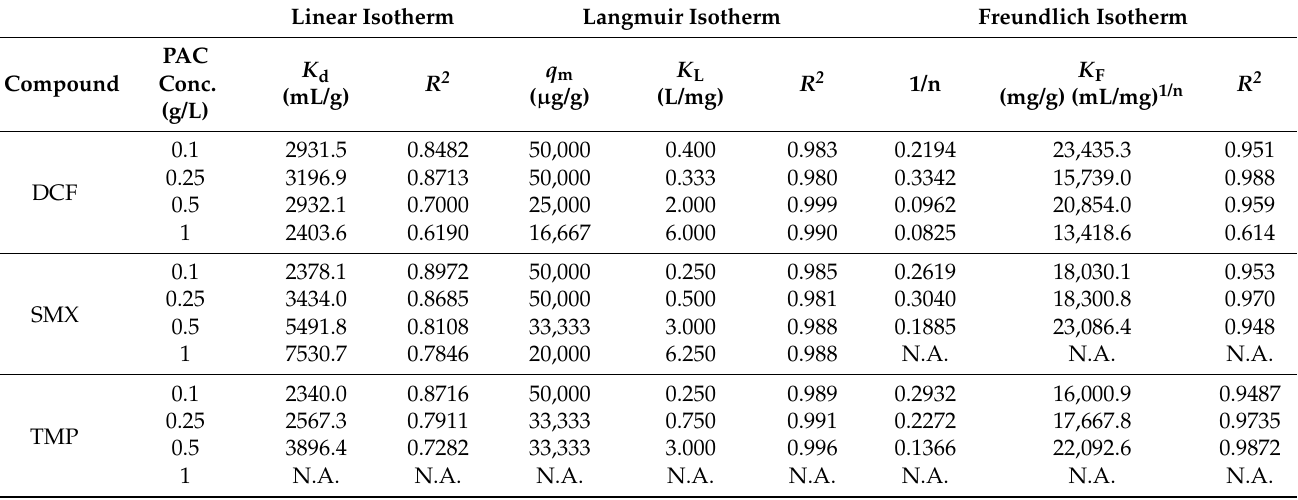
Table 6. Distribution coefficient ( K d ) and Langmuir and Freundlich isotherm parameters, together with the corresponding regression coefficients ( R 2 ) for the adsorption DCF, SMX and TMP onto PAC in a humic acid solution with 24 h pre-contact time between the pharmaceuticals and the humic acids. Not applicable (N.A.) indicates that the parameters could not be obtained, as the residual concentration found in the liquid phase was too low to conduct the